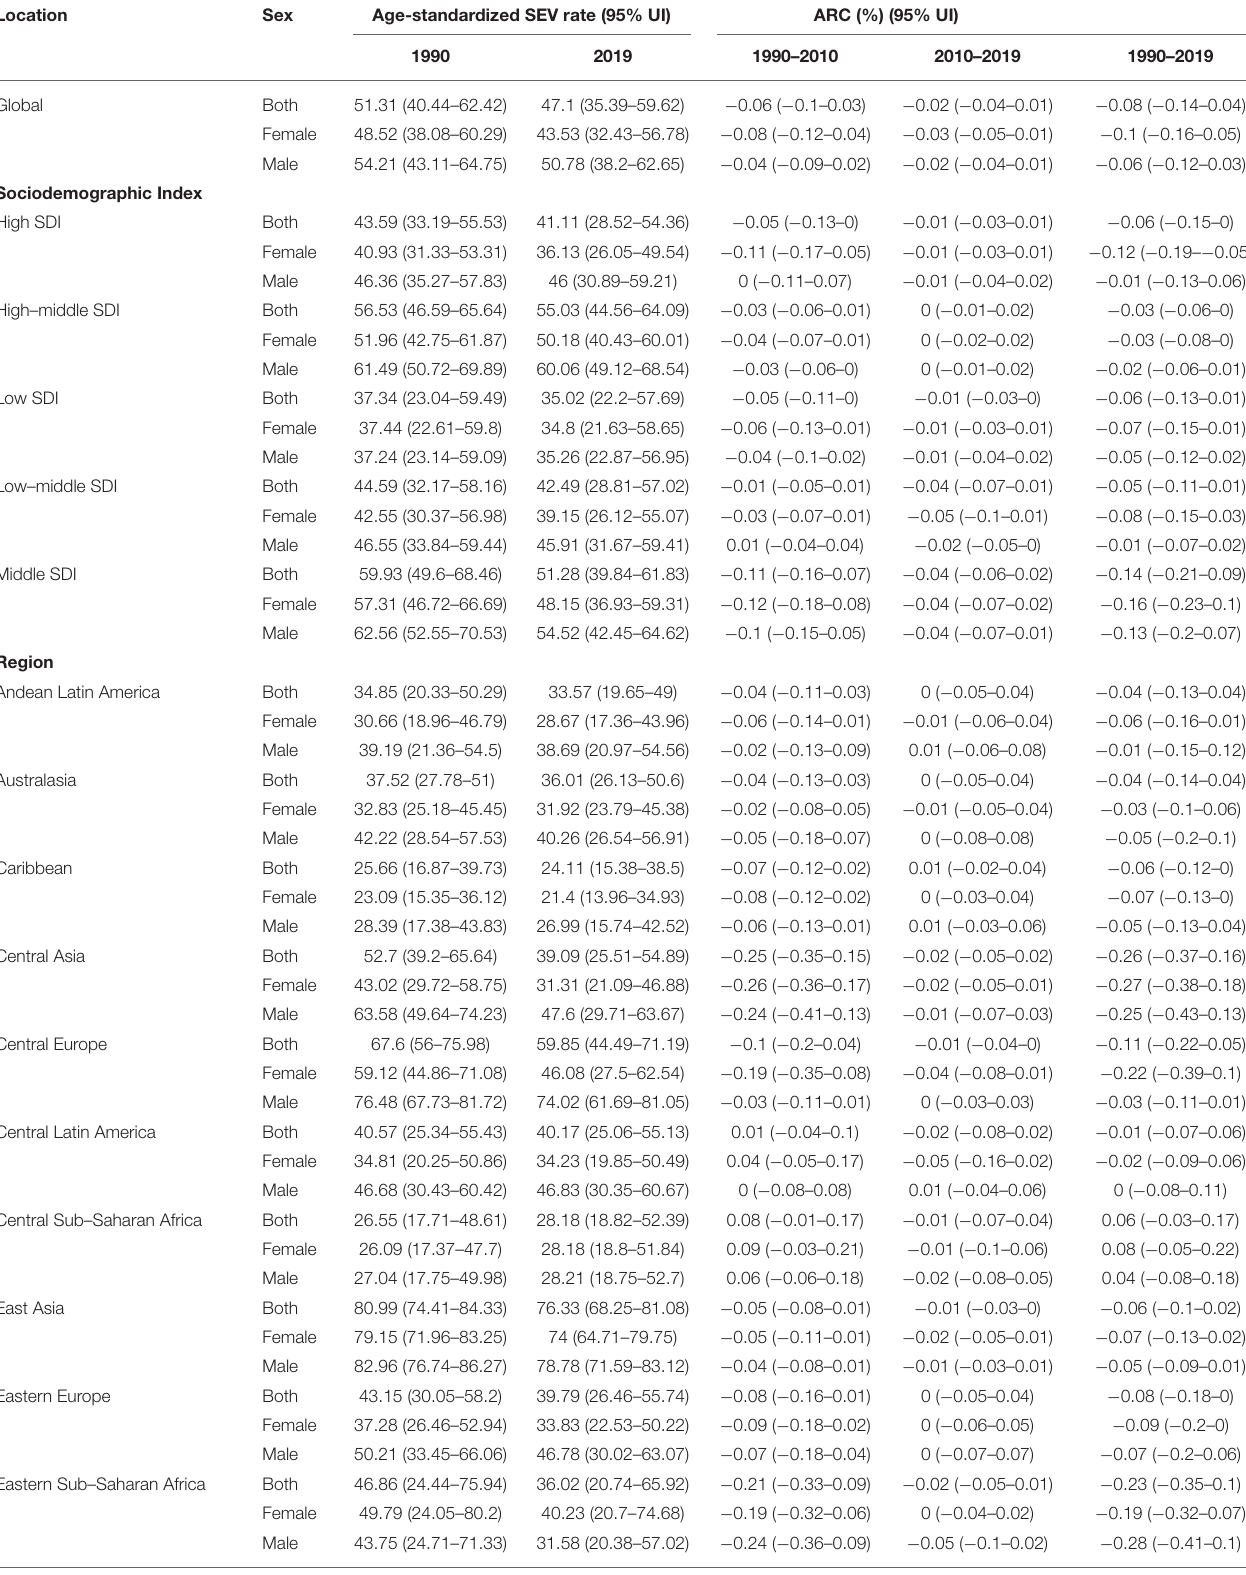
TABLE 1 | Age-standardized summary exposure value rates of dietary risks related to colorectal cancer and annualized rate of changes.